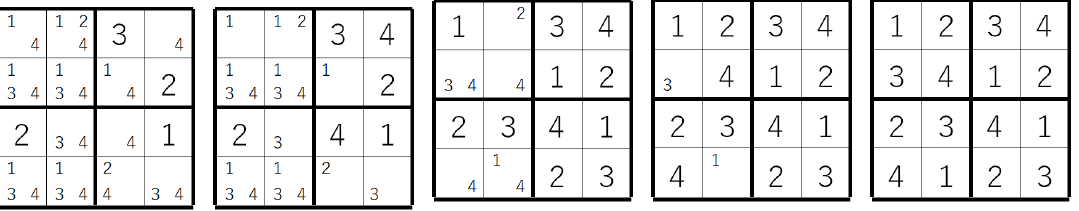
Figure 5. Sequence of grids in a 4 × 4 Sudoku, evolving from the left-most initial state to the right-most final state. Larger digits are determined ones and smaller digits are